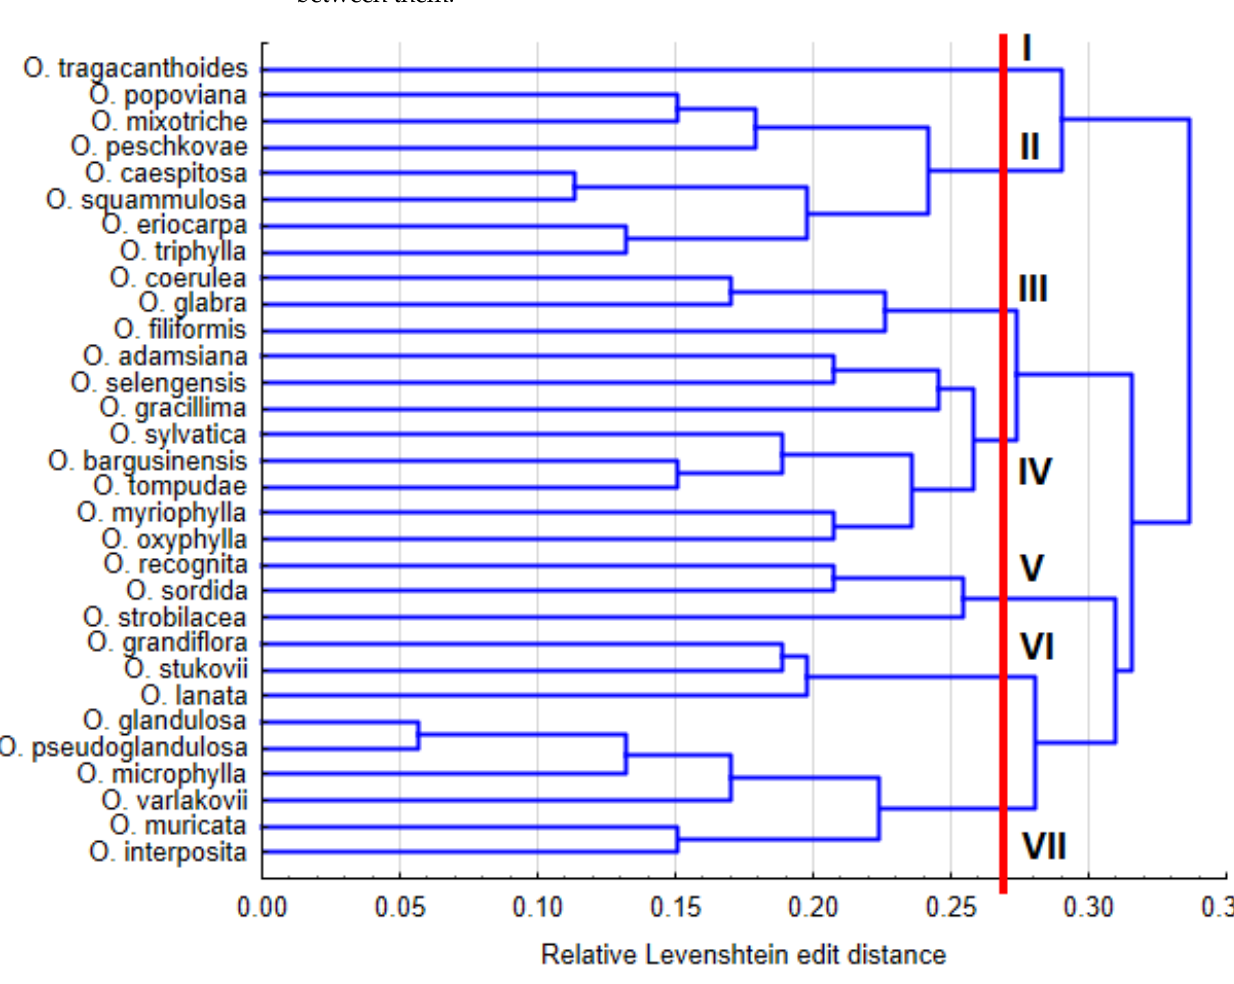
Figure 2. WPGMA similarity dendrogram of 31 Oxytropis species based of relative Levenshtein edit distance.